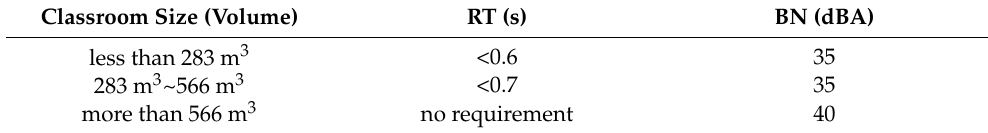
Table 1. Acoustic performance standards for classrooms in the United States (unoccupied). m 3 . Classroom Size (Volume)